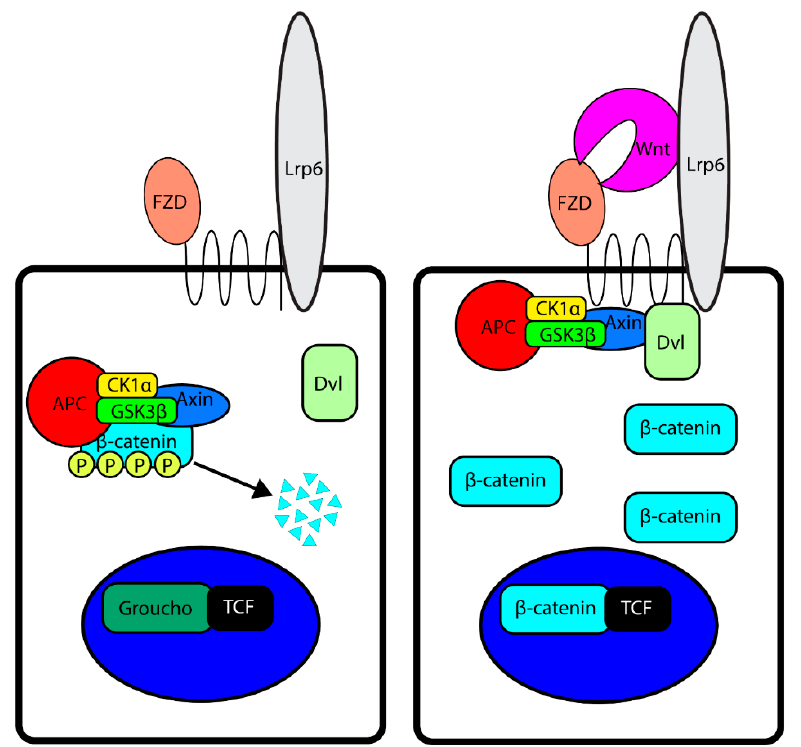
Figure 1. General model for the Wnt/ β -catenin signaling pathway and its regulation by the destruction complex. The destruction complex: Axin, Adenomatous polyposis coli (APC), casein kinase 1 α (CK1 α ), glycogen synthase kinase 3 (GSK3), protein phosphatase 2A (PP2a), and the ubiquitin ligase β TrCP. Membrane receptors: Frizzled (FZD) and low-density lipoprotein receptor-related protein 6 (Lrp6). Dishevelled (Dvl) T-cell factor (TCF).